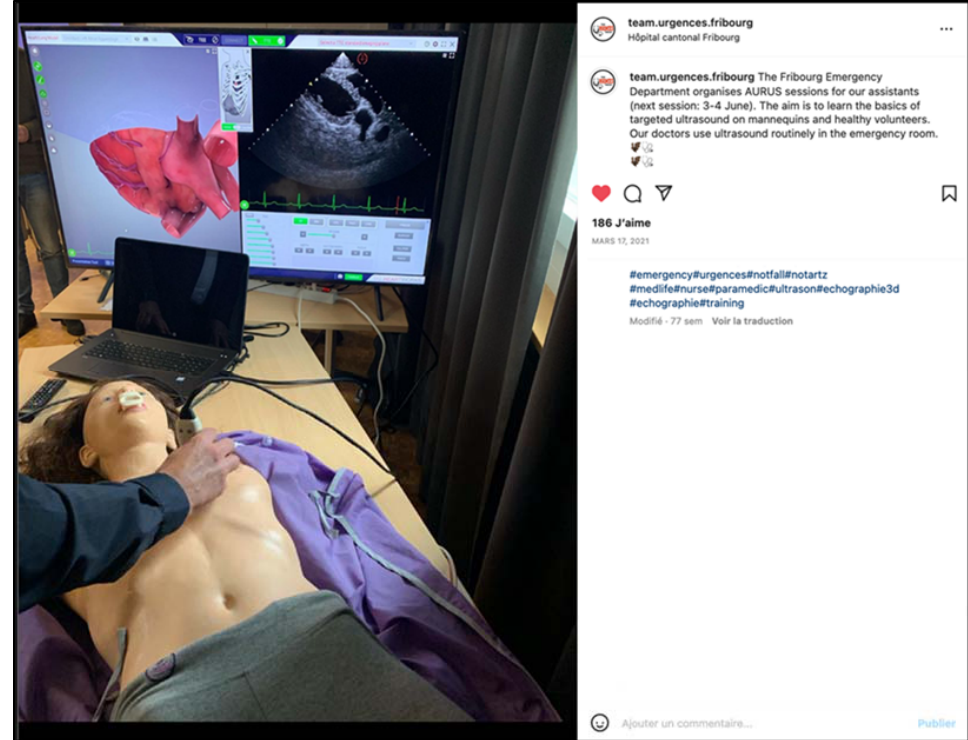
Figure 7. Illustration of the means made available for the student training (here depicting ultrasound) (screenshot).